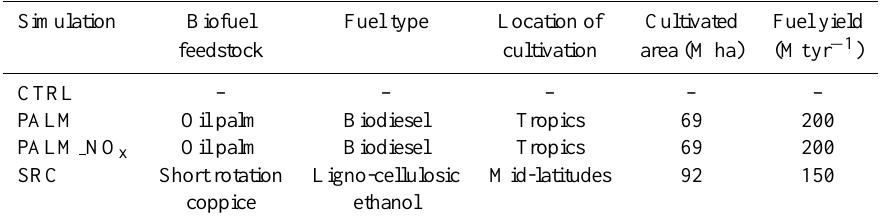
Table 1. Overview of